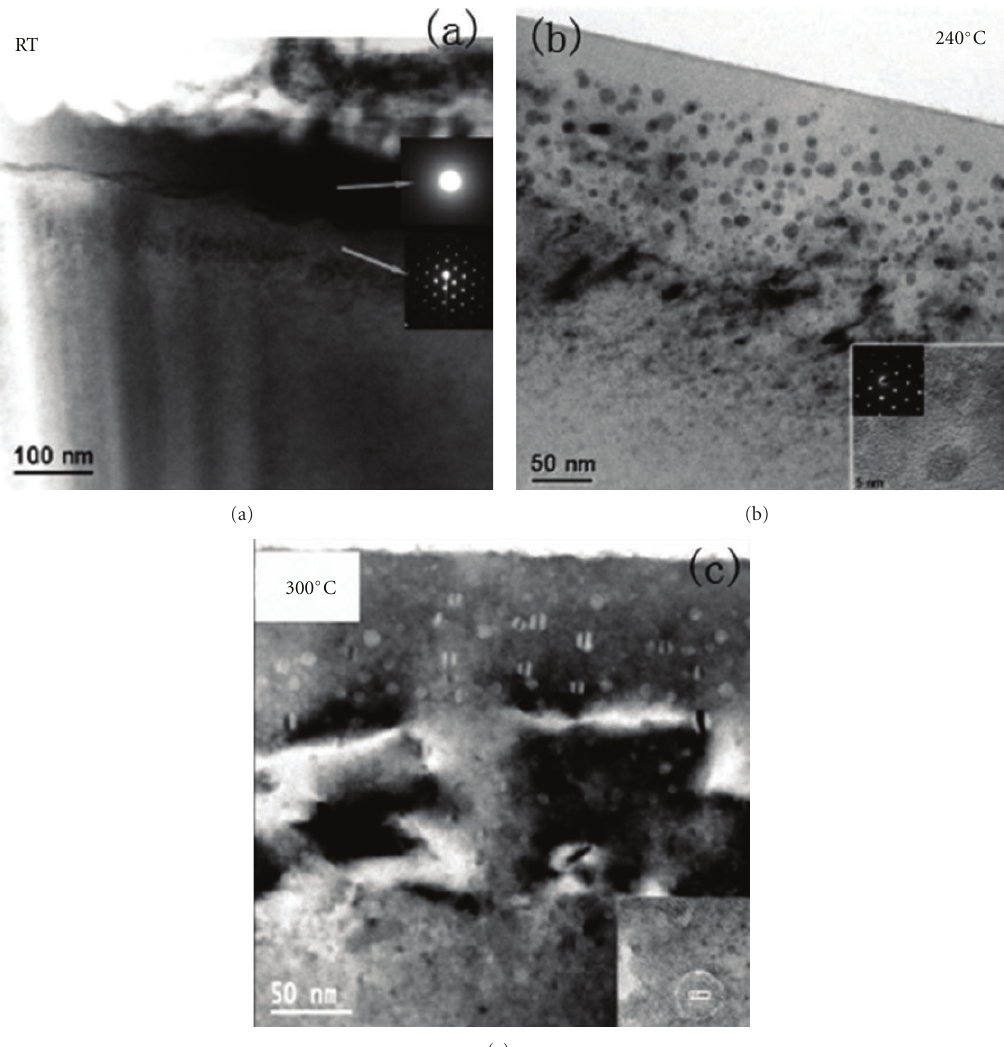
Figure 3: Bright-field cross-sectional TEM images of the GeMn samples implanted at various temperatures (same Mn dose of 2 × 10 16 at./cm 2 ). Insets in (a): electron di ff raction patterns taken in the zones marked by the arrows. Inset in (b): high resolution close-up of an amorphous nanocluster and electron di ff raction pattern taken in the same zone. Inset in (c): high resolution close-up of a crystalline nanocluster. Reproduced from [10]. Copyright ©2007, WILEY-VCH Verlag GmbH & Co. KGaA,